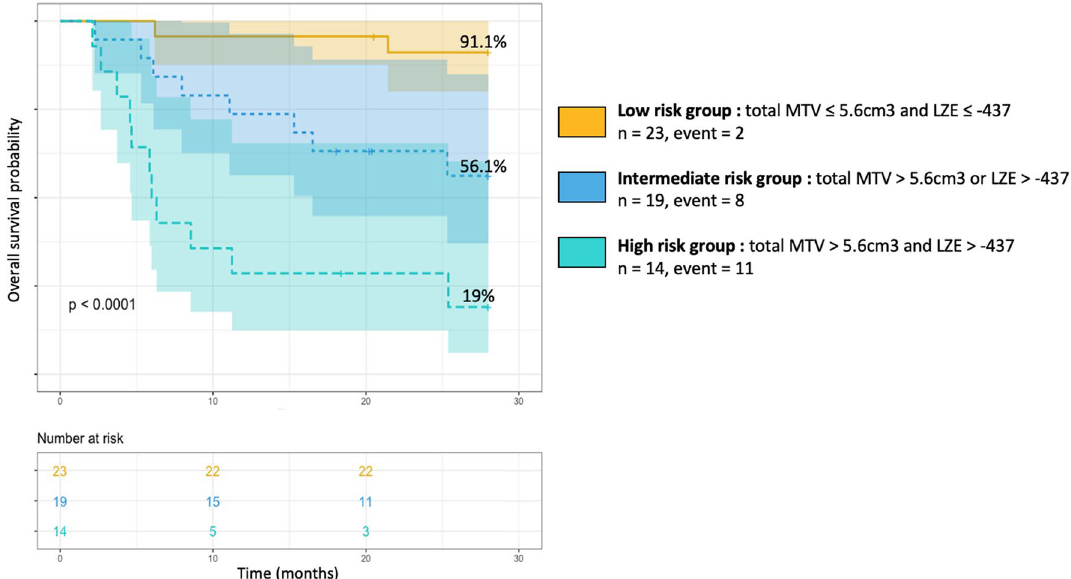
Figure 2. Kaplan Meier curves of overall survival (OS) based on a metabolic score combining total metabolic tumoral volume (total MTV) and long zone emphasis (LZE). The combined score comprising two binary risk variables was defined as follows: 0 risk variable = low risk group (total MTV ≤ 5.6 cm 3 and LZE ≤ − 437), 1 risk variable = intermediate risk group (total MTV > 5.6 cm 3 or LZE > − 437) and 2 risk variables = high risk group (total MTV > 5.6 cm 3 and LZE > −